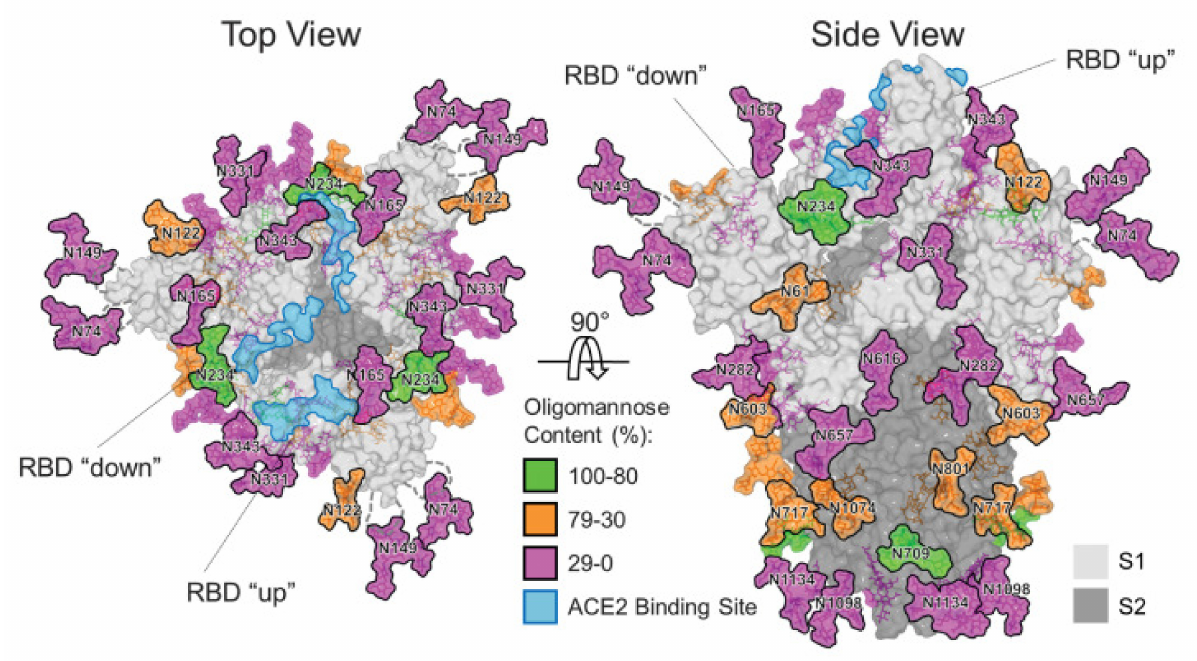
Figure 2. Structural-biology-based glycosylation map of the trimeric S protein of SARS-CoV-2. The green, orange and pink regions represent different amounts of high-mannose-type glycans shielding regions of S protein. The blue regions are the host ACE2 binding site essential for virus entry into the host cell. The figure also illustrates the ‘up’ conformation and ‘down’ conformation of two of the three receptor binding sites (RBD), which is only accessible for ACE2 or antibody binding when it is in ‘up’ conformation. Reprinted from Watanabe et al. [20]. The permission to reprint was granted by